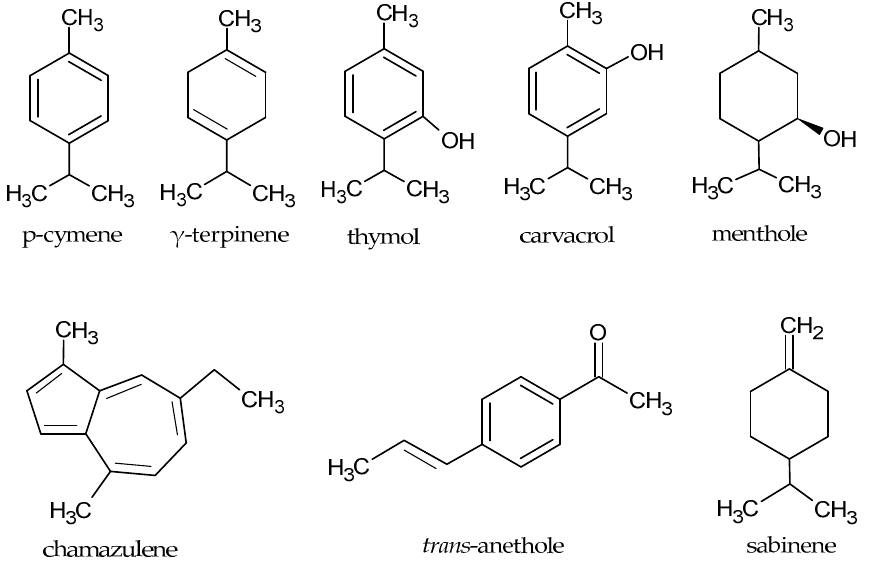
Figure 2. The chemical structures of major constituents identified by GC-MS analysis from studied families.